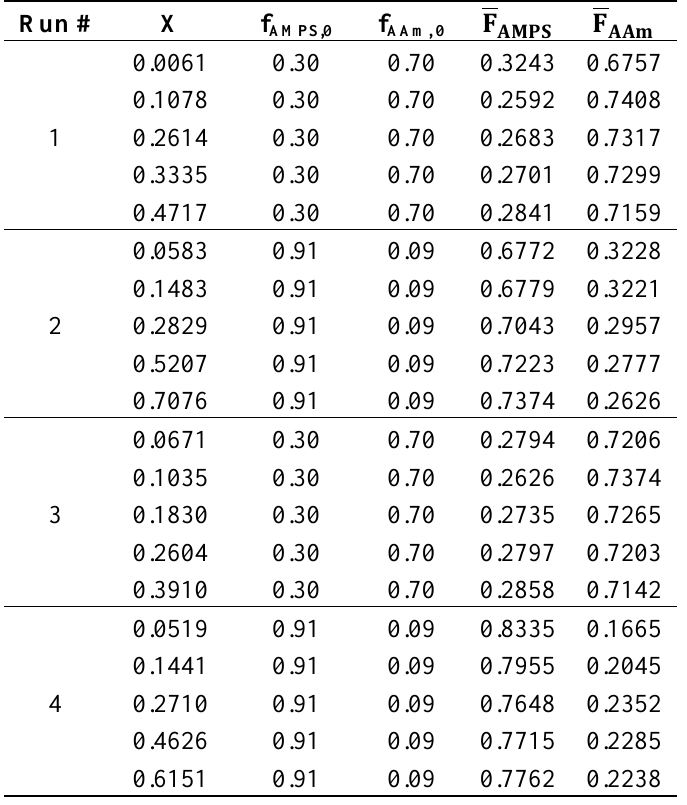
Table A1. Experimental data for AMPS/AAm copolymerization; Tidwell-Mortimer design.